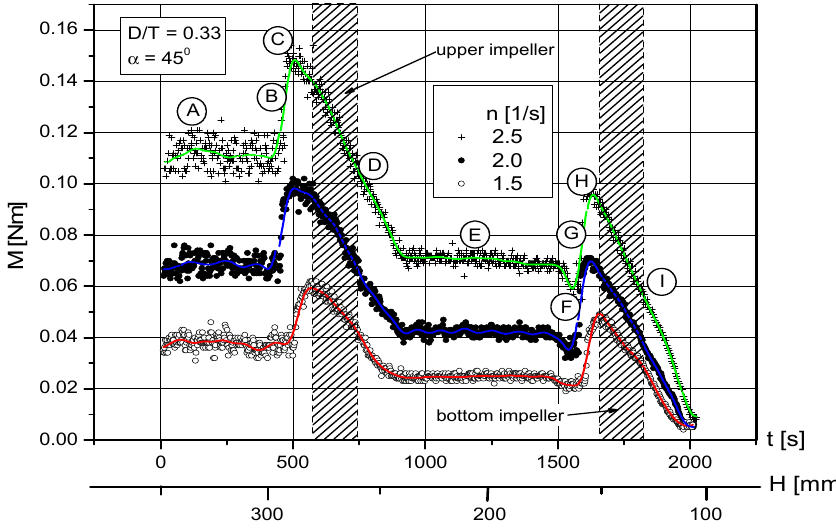
Figure 3. Changing the torque of the impeller when emptying the